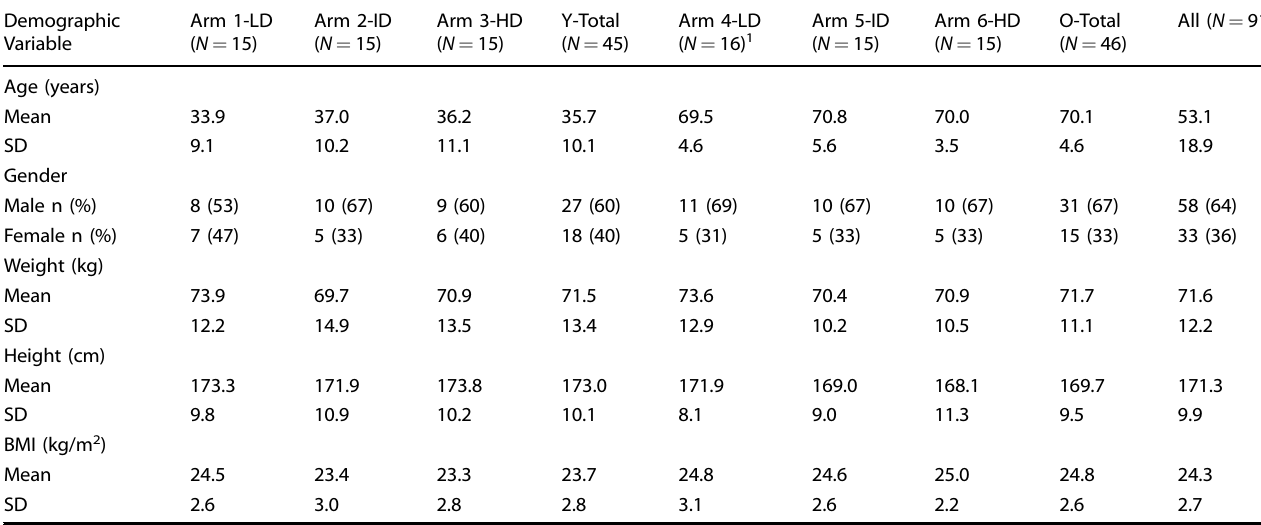
Table 1. Study arms and volunteers characteristics. Demographic